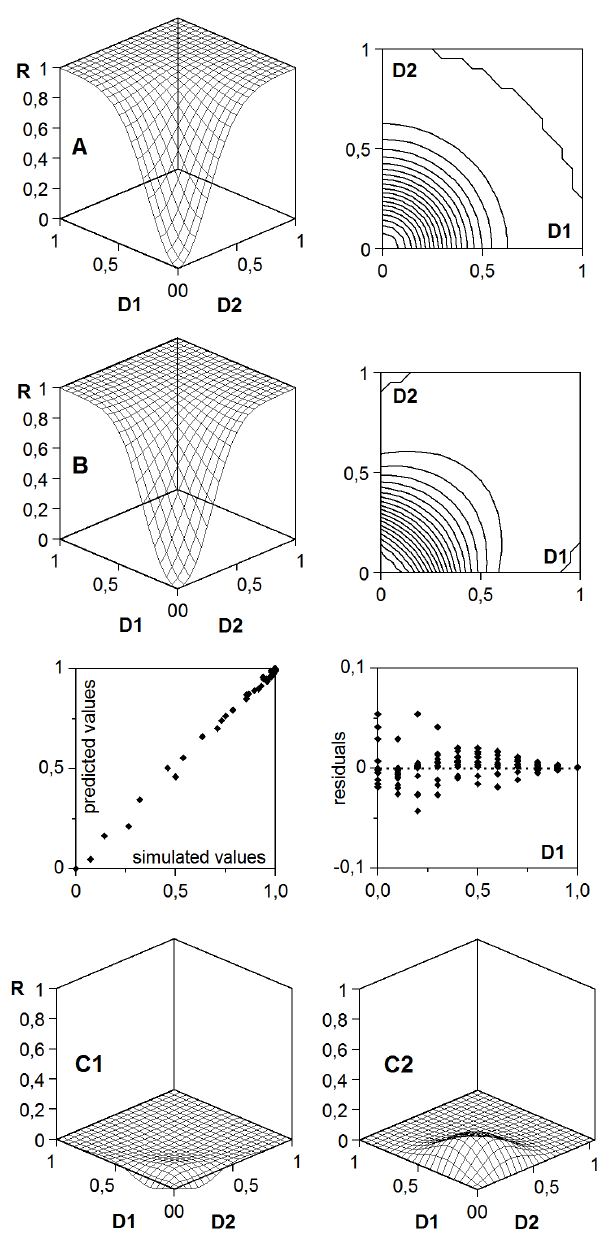
Figure 10. An example of ambiguous interpretation of a response through IA and CA hypothesis. A: IA response surface (defined by K 1 = K 2 =1.00; m 1 = m 2 =0.30; a 1 = a 2 =2.00). B: result obtained when this surface is interpreted, through CA hypothesis, as a case of symmetrical antagonism ( K =1.00; m =0.316; a =2.348; c D2 = c D1 =1.311. All coefficients statistically significant, with a =0.05). Notice the lack of residual randomness. C: differences between CA minus IA (C1) and CA null interaction minus CA antagonism (C2)